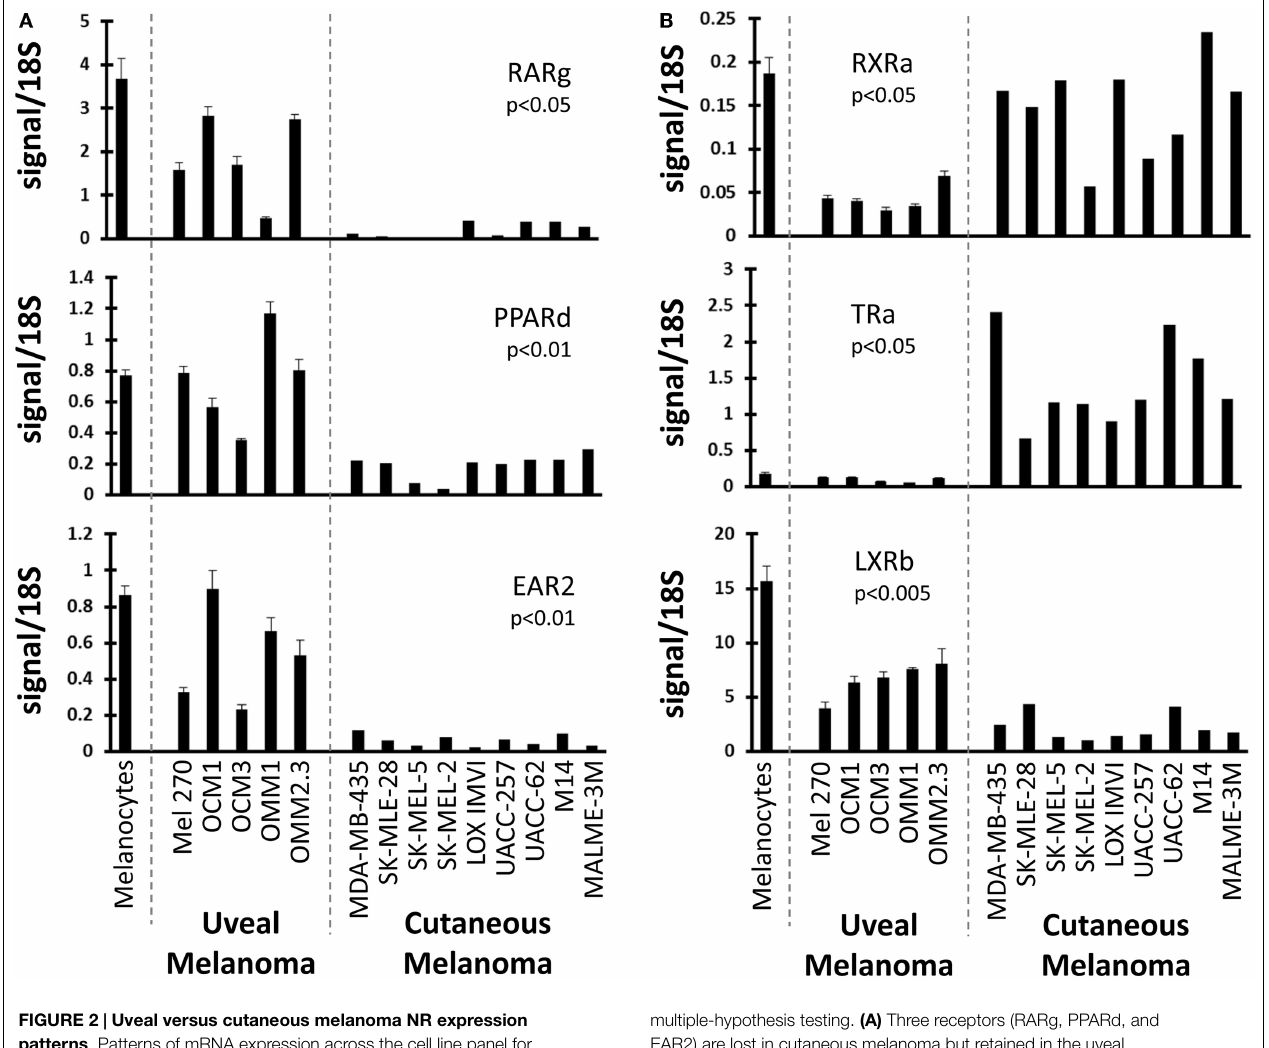
FIGURE 2 | Uveal versus cutaneous melanoma NR expression patterns . Patterns of mRNA expression across the cell line panel for select receptors. p -Values are shown for the comparison of the expression level of the indicated nuclear receptor between uveal and cutaneous melanoma cell lines. Calculations were performed using a Student’s t -test and were Bonferroni-corrected for to account for